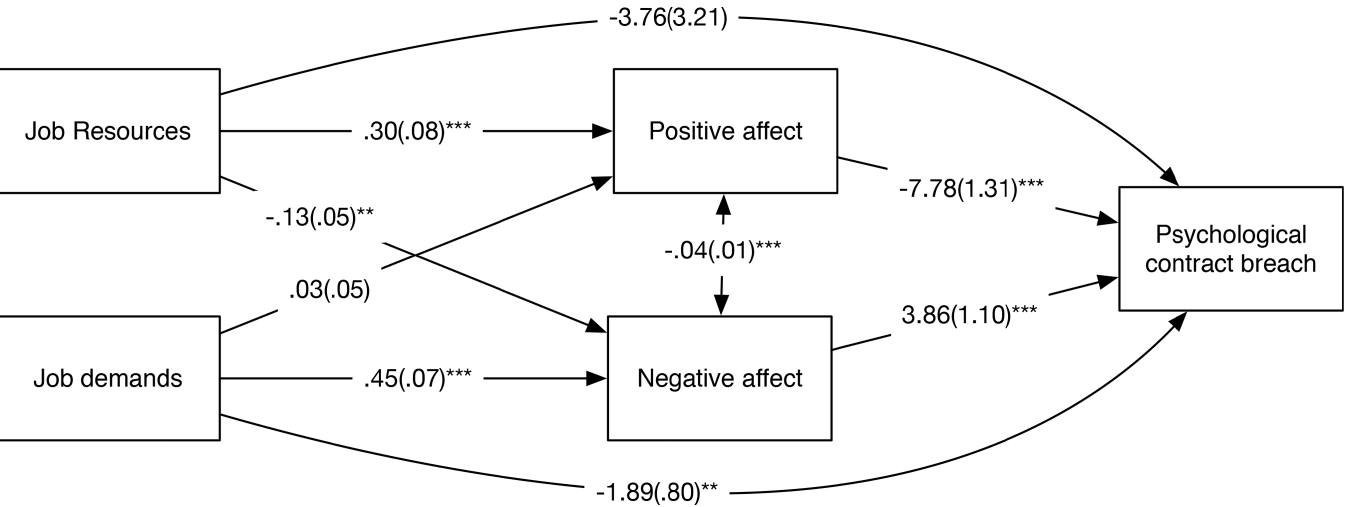
Fig 2. Path estimates from model with concurrent relationships in Study 2. * : p < .05, ** : p < .01, *** : p < .001. Standard errors between parentheses.